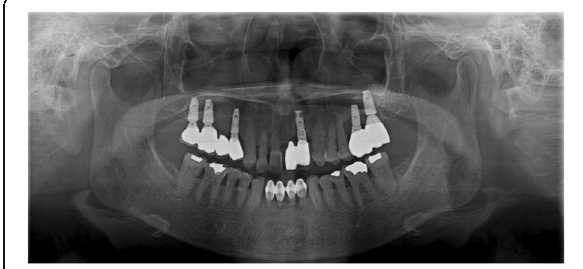
Fig. 9 F2, the final panoramic radiograph showing bone loss at #26i and